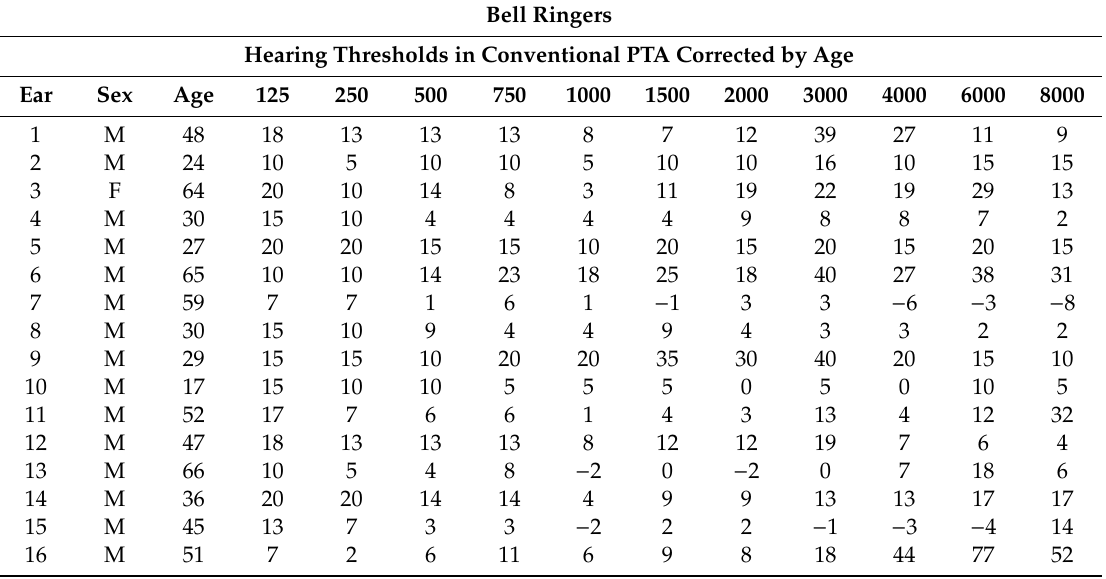
Table 8. Hearing thresholds of the control group without correction by age. Bell